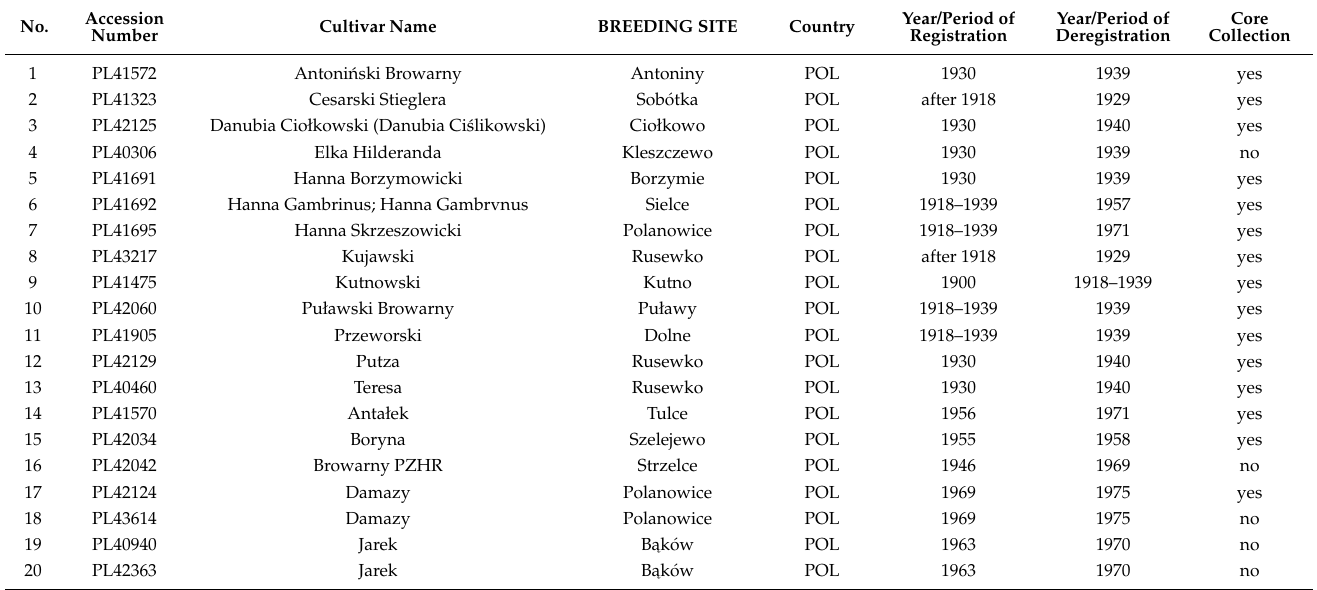
Table 6. The list of spring barley cultivars analyzed by